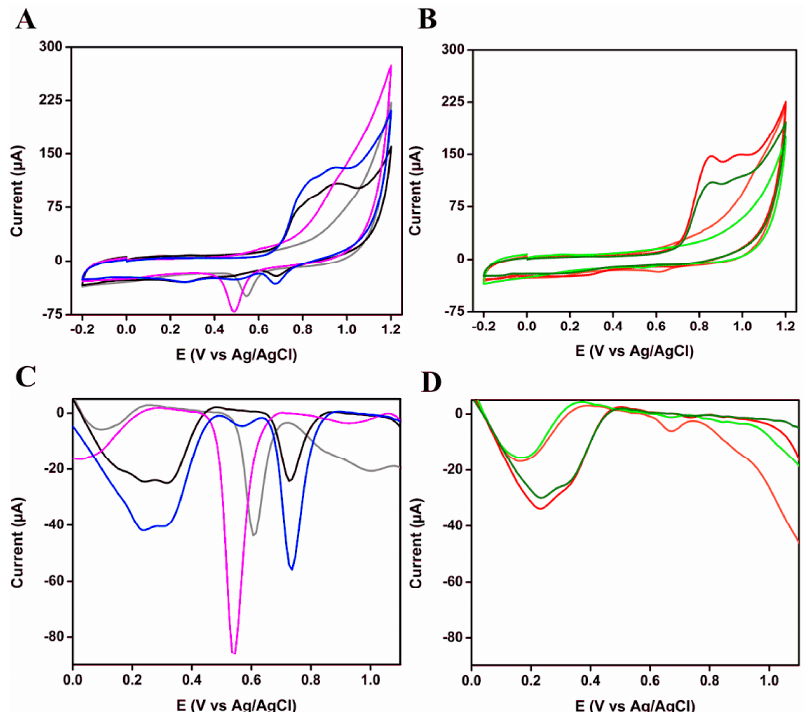
Figure 4. ( A ) CVs and ( C ) DPVs of 1 mM VAN in 0.1 M H 2 SO 4 and the blank solutions